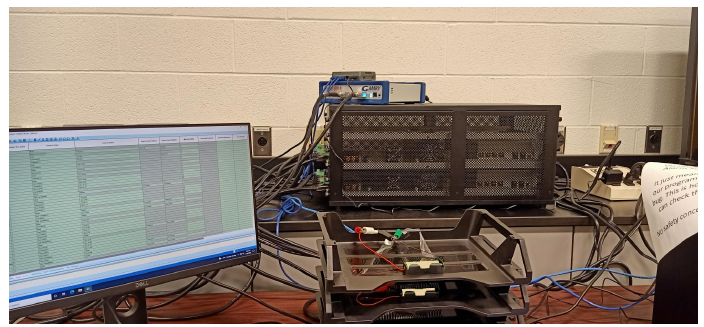
Figure 12. Experimental